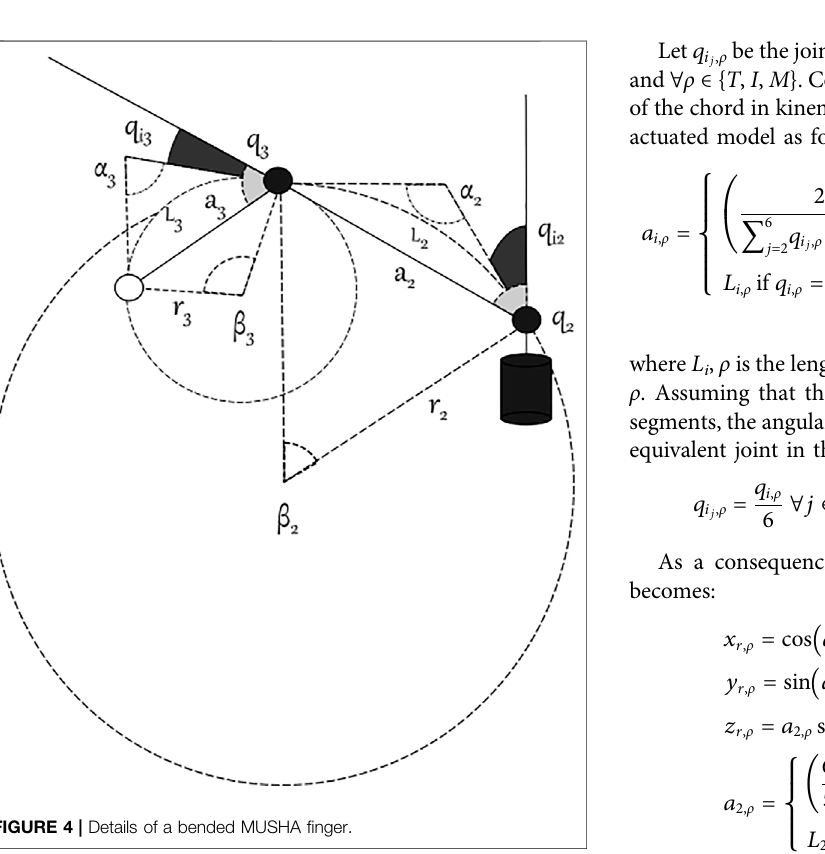
FIGURE3| MaingraspingmethodofMUSHA, fromleft torightare respectively depicted theapproach posesincase ofprecision grasp (Pr)in A,power grasp (Po) in B and retractor (Rt) in C.